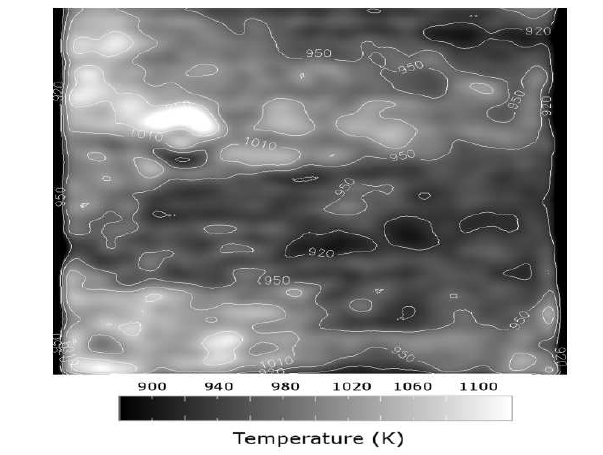
Figure 44. Surface temperature map of a section inside an afterburner